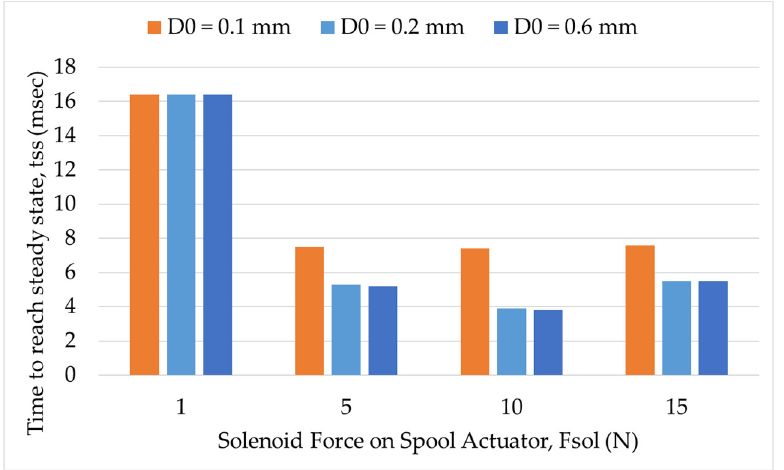
Figure 15. A summary of valve’s agility for different values of solenoid force and damping